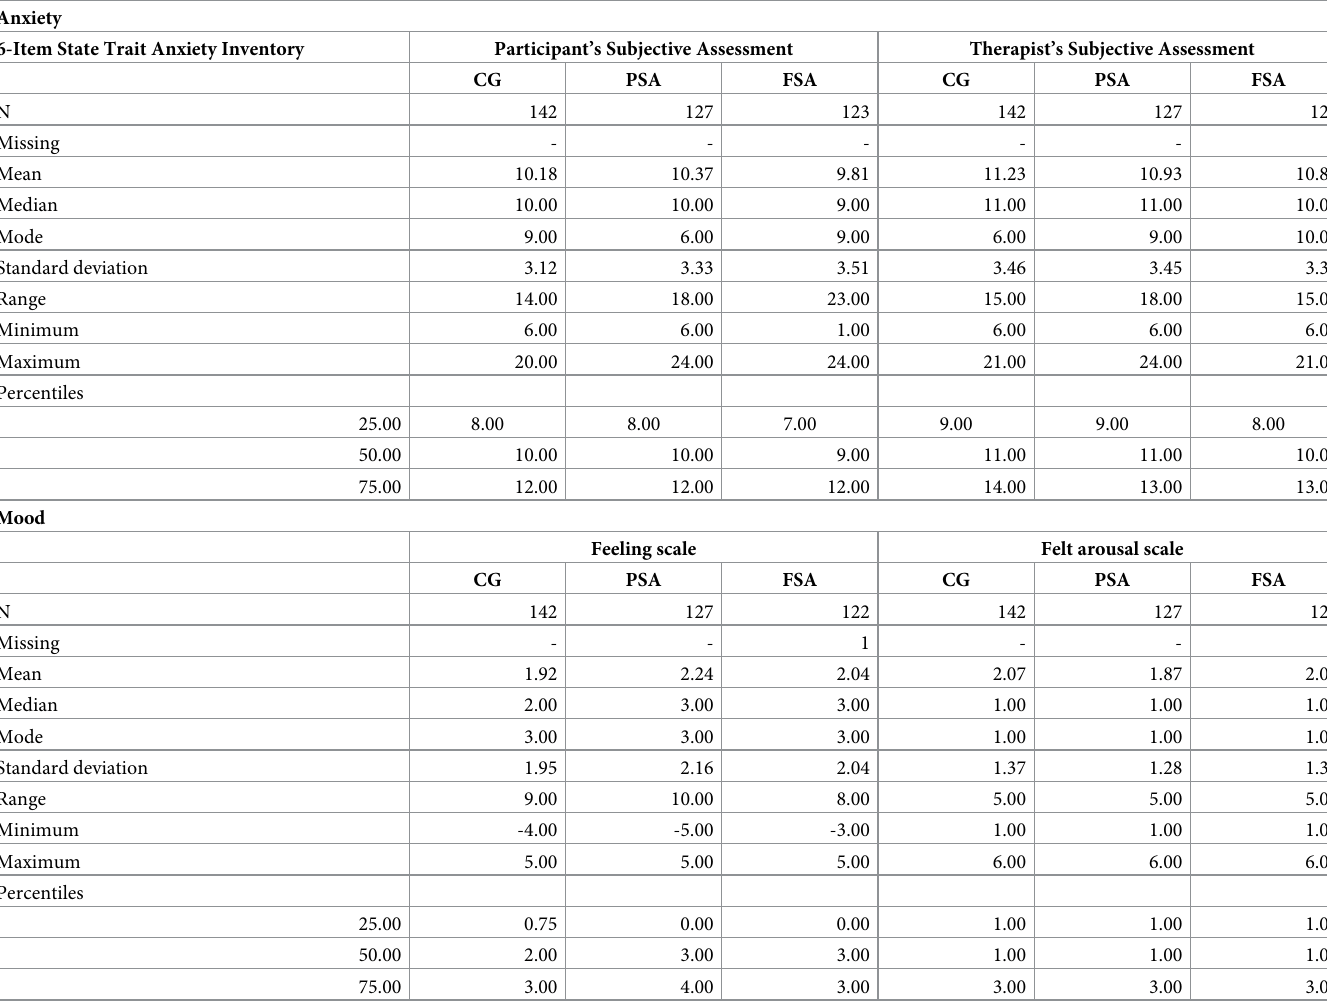
Table 5. Descriptive analysis of the results of the anxiety, mood of the participants in the different waiting area settings.